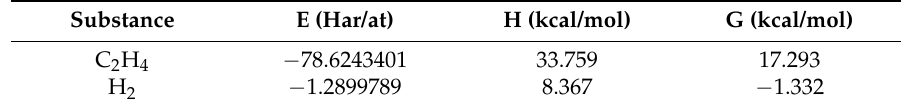
Table 5. The total energy and thermodynamic properties of each component during (C 2 H 5 ) 3 Al decomposition at 298.15 K.